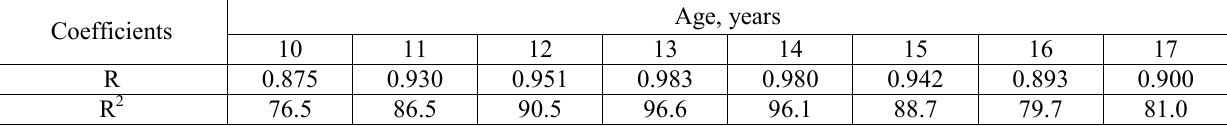
Coefficients of multiple correlation ® and determination (R 2 ) between results of running high jumps and motion abilities’ levels of 10-17 years old